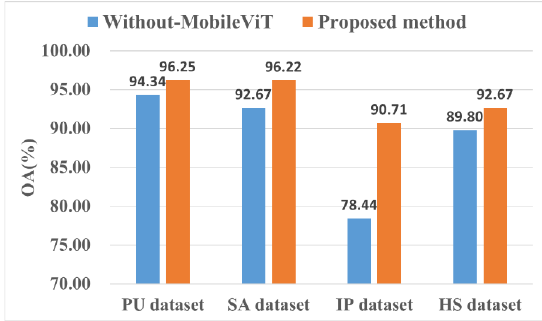
Figure 13. Effectiveness of the